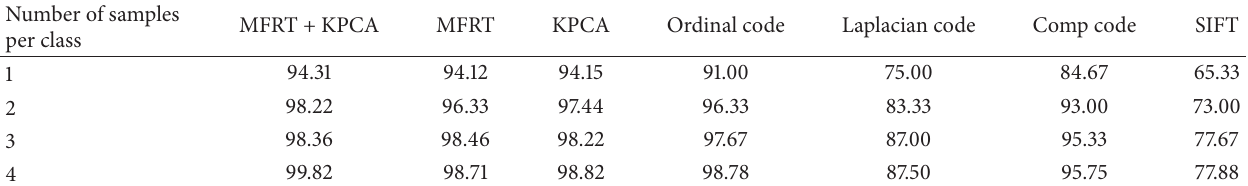
Figure 6: Receiver operating characteristics from the CASIA database: (a) left palm, (b) right palm, and (c) left and right palm. Table 1: Accuracy measures from CASIA left hand multispectral palm print